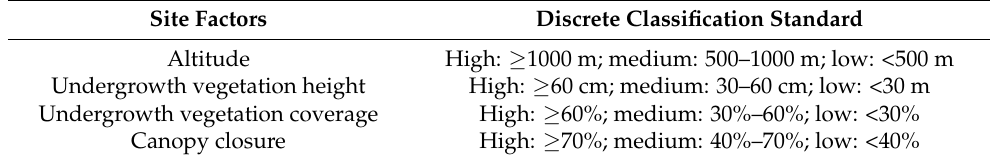
Table 3. The discretization of continuous site factors. Site Factors Discrete Classification